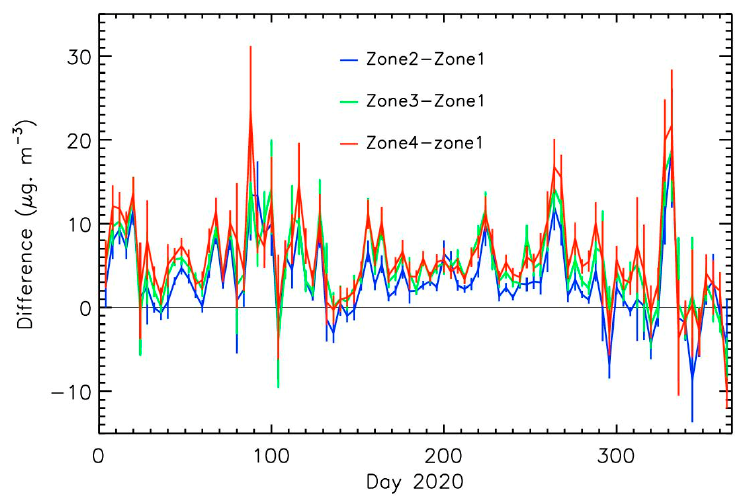
Figure 13. Temporal evolution of the differences between zones 2 to 4 and zone 1.